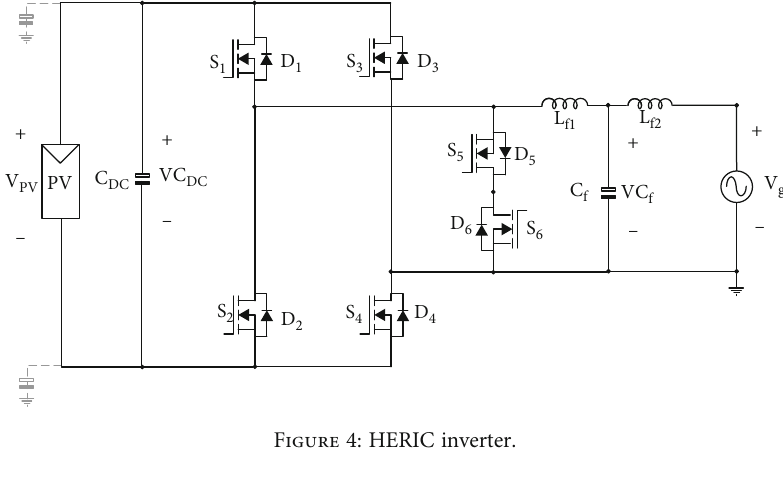
Figure 4: HERIC inverter.